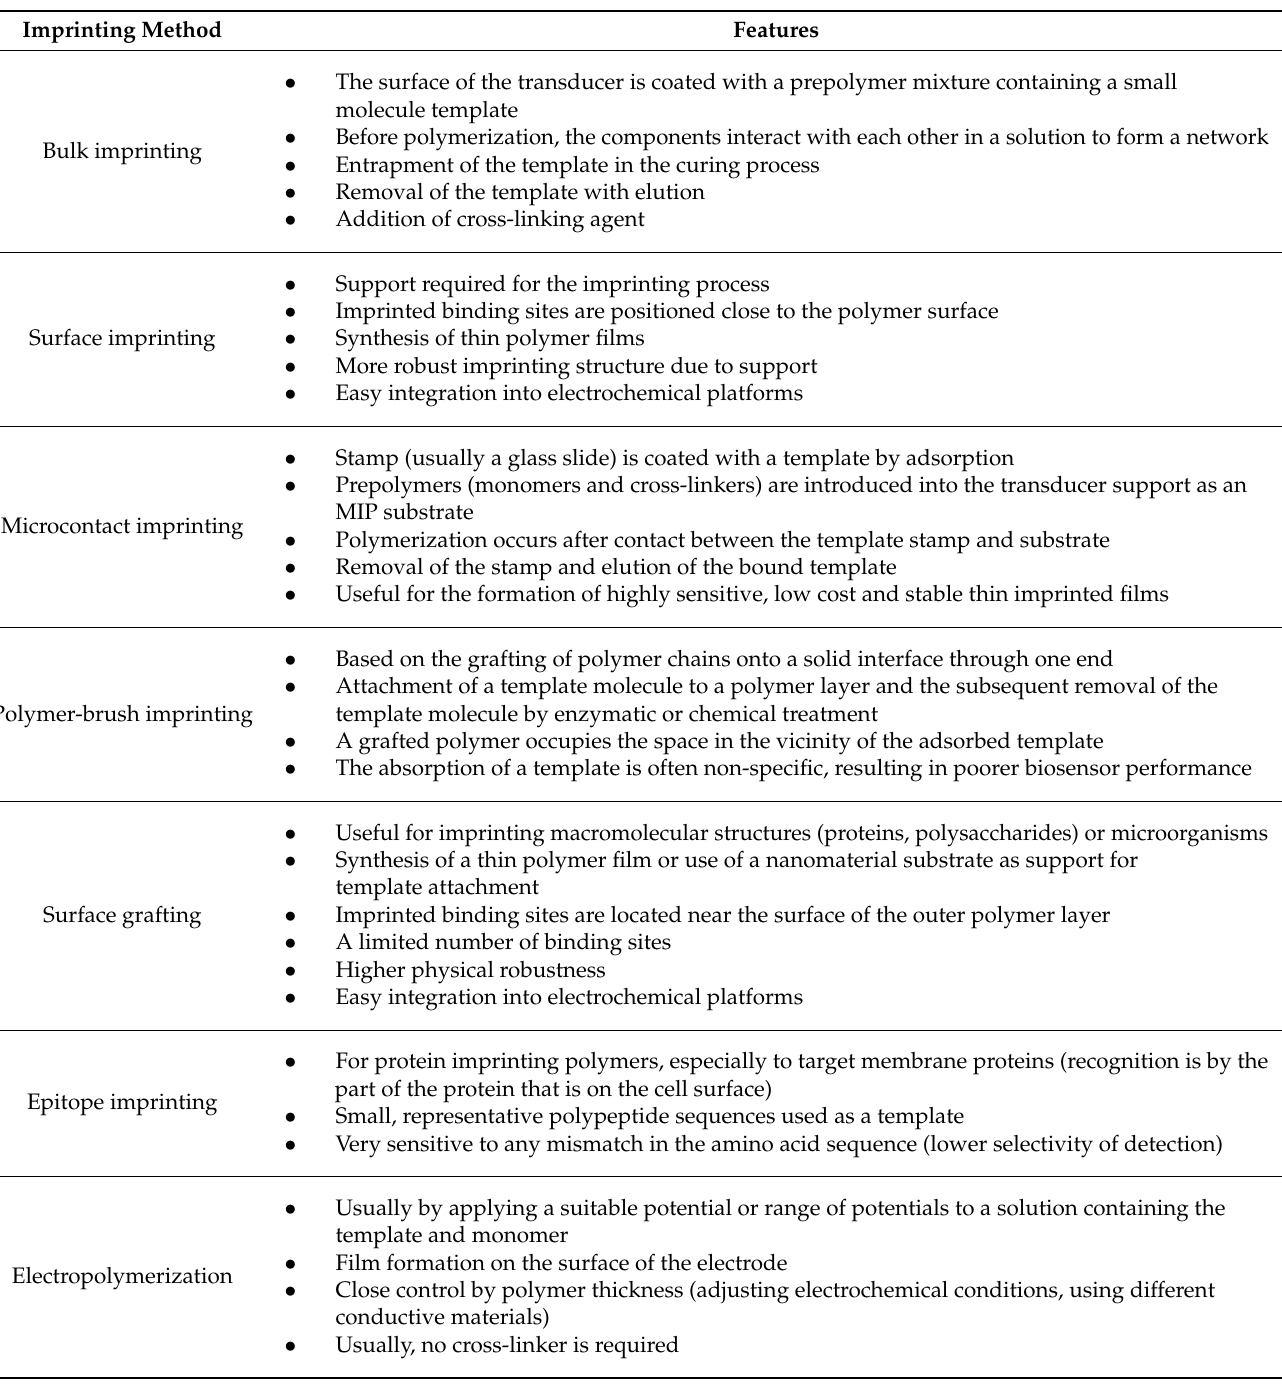
Table 1. Different synthetic routes for MIP